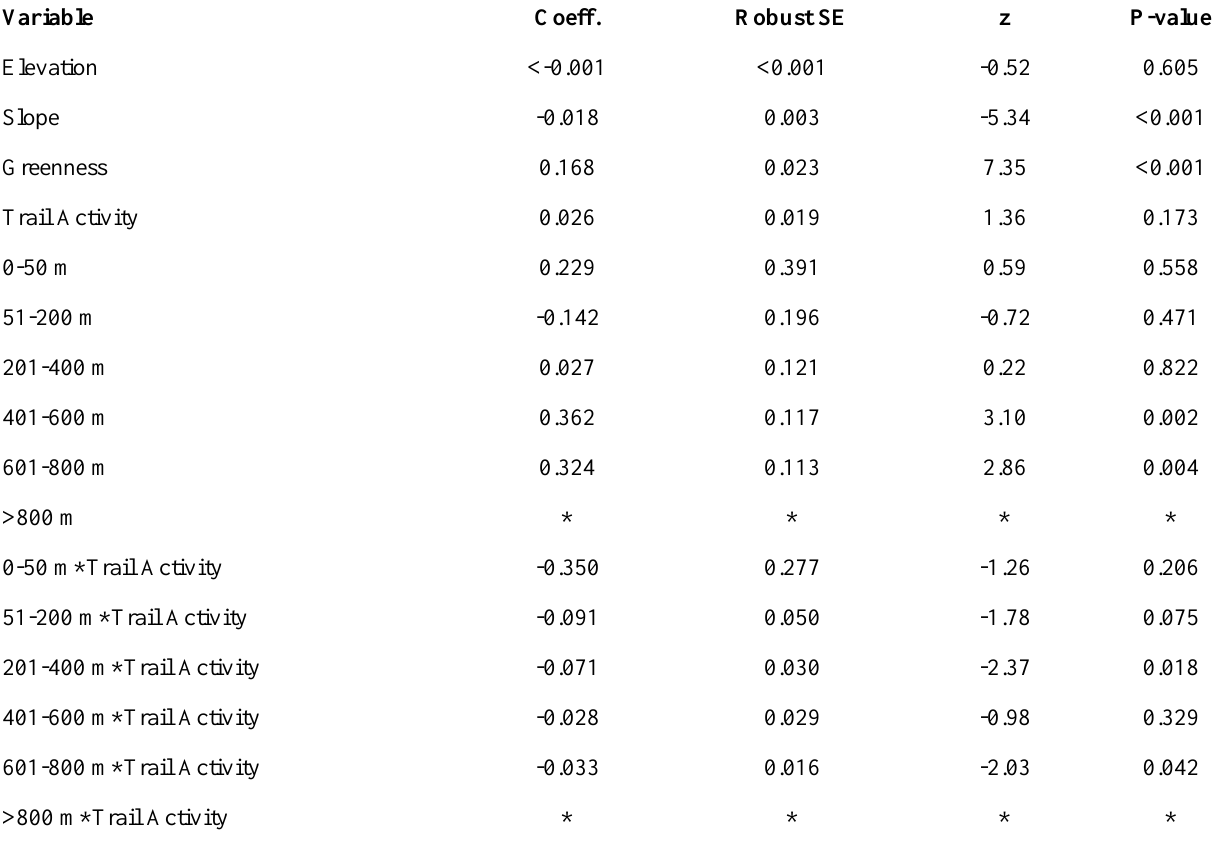
Table A1.3 . Model results for elk near trails. Results predict elk occurrence near trails using matched case-control logistic